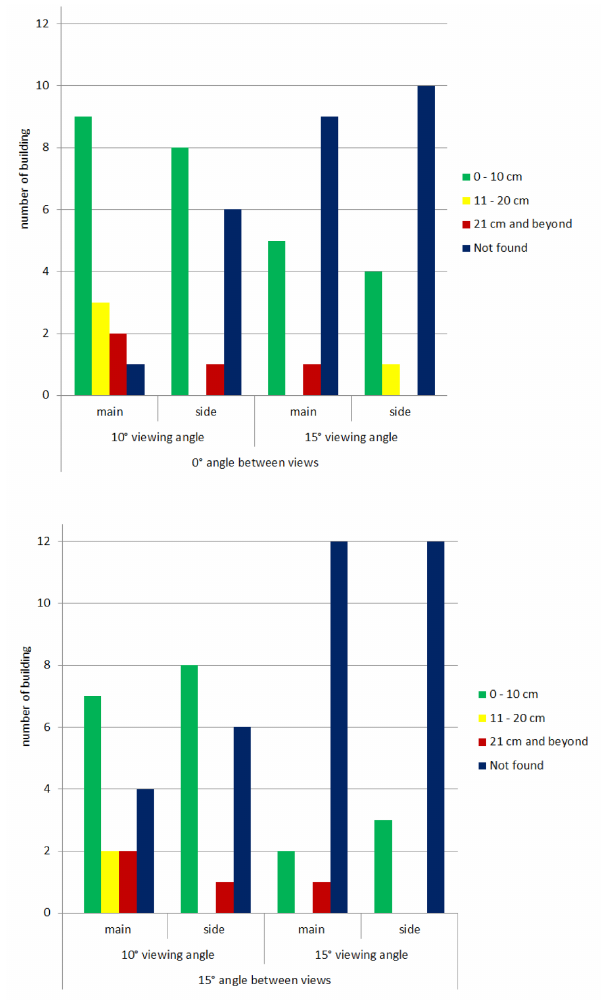
Figure 5: Comparison of roof overhang with field survey mea- surement. Overhangs are estimated without taking into account the occlusion from other